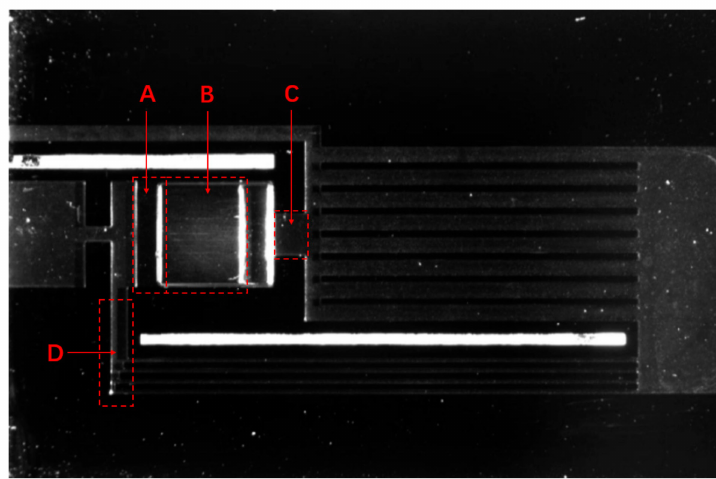
Figure 11. s-UTLHP structure